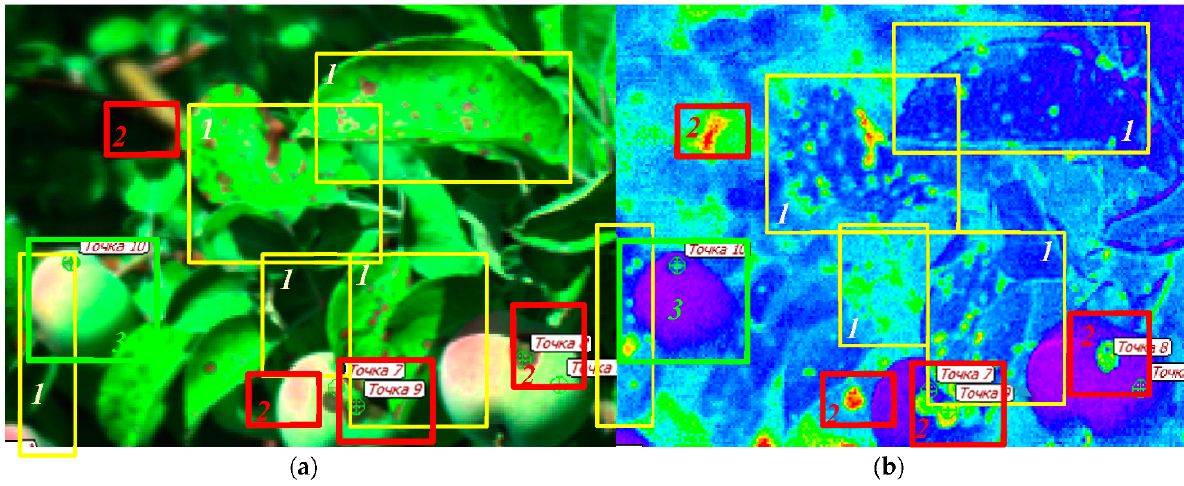
Figure 6. Using the mBRI index for the detection of profound apple scab-induced damages in the HRI images of unripe Ligol apple fruits and leaves obtained at ambient illumination (see also Figure S4). ( a ) The scene in RGB composite color (as perceived by the human eye and reconstructed from a HRI obtained in a commercial orchard). ( b ) The same scene in false color representing the calculated values of the mBRI index. The magenta-blue regions represent unaffected leaf and fruit area, the green-red areas are affected by the scab-induced browning. The rectangles outline the damaged leaves ( 1 ), fruits ( 2 ) as well as a healthy fruit ( 3 ) in a and b. Note the fruit damages (in the left) is hardly visible on the RGB images due to shading but readily discernible in the mBRI index image. Violet-to-blue colors correspond to the low mBRI values (healthy tissues), green-to-red colors correspond to high mBRI values (severely affected tissues).